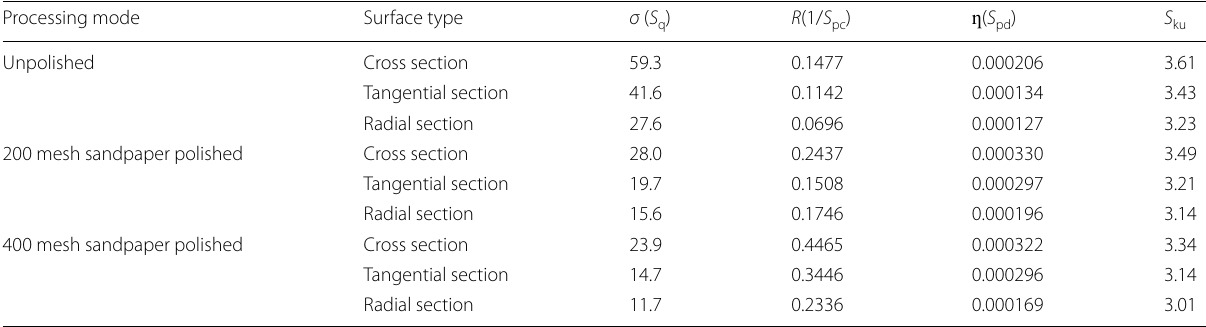
Table 2 Surface morphology parameters of wood Processing